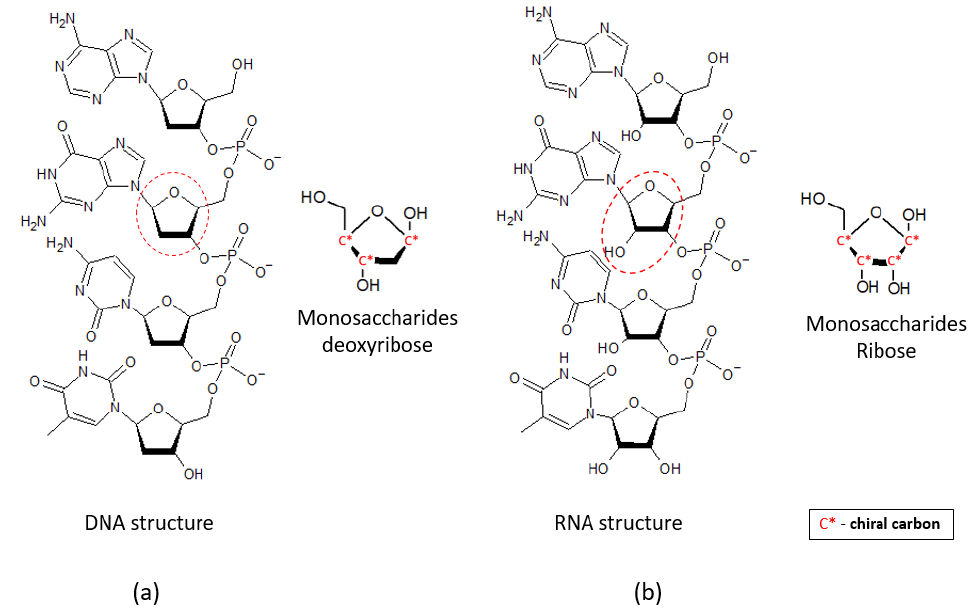
Figure 6. Deoxyribose ( a ) and ribose ( b ) monosaccharides structural formulas from DNA and RNA and their chiral carbons. Table 3. Difference in biological activities between enantiomers [4].